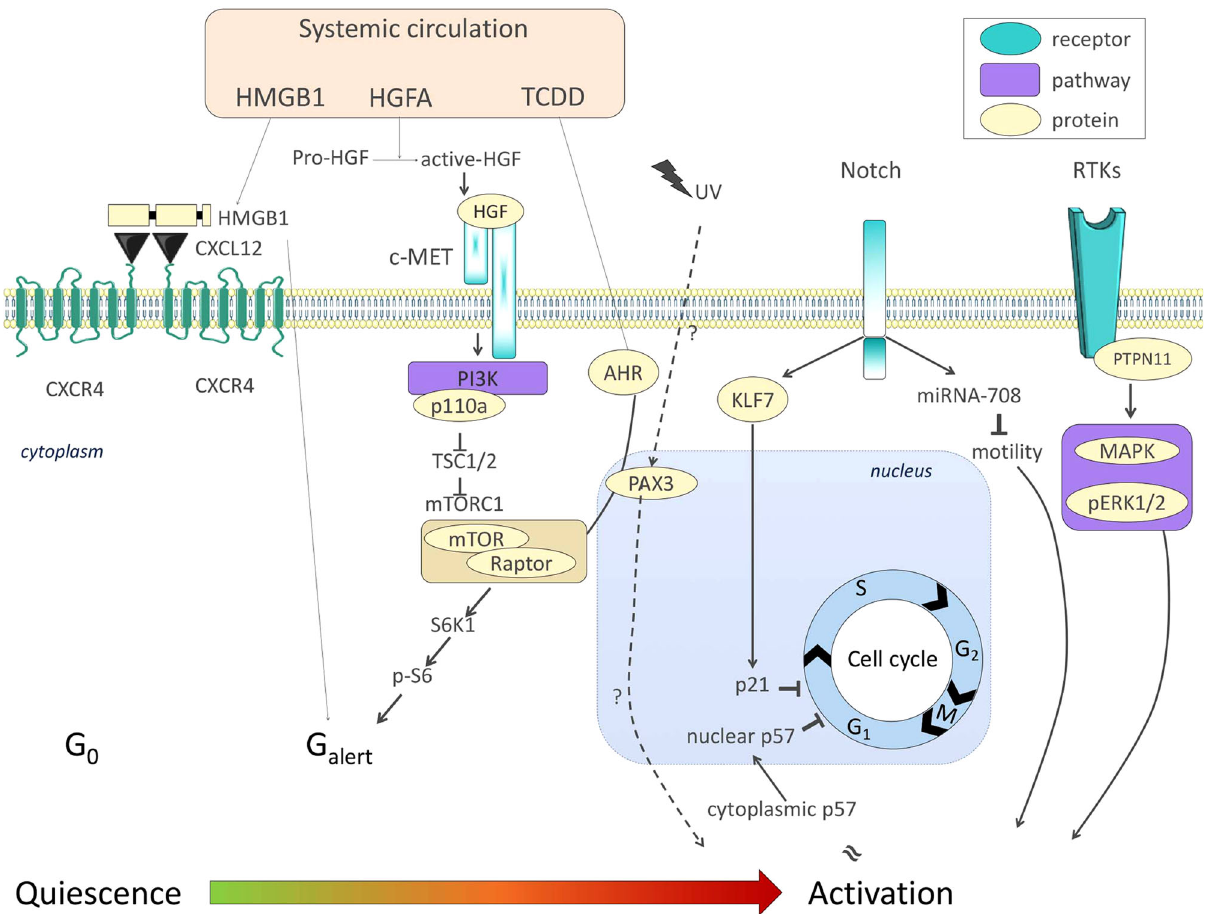
Fig. 1 Signaling pathways involved in MuSC transition from quiescence to activation. Systemic signals such as HMGB1, HGFA, and the environmental pollutant TCDD (commonly known as dioxin) promote G alert features in MuSCs through mTORC1 signaling. The Notch signaling pathway, critical for the maintenance of the quiescent state of MuSCs, was recently described to block proliferation and activation through KLF7-p21 and miRNA-708-Notch- migration axes, respectively. Finally, PTPN11/MAPK signals and cytosolic p57 are compatible with proliferation and activation of MuSCs. Color code: blue, receptor; beige, protein; purple,